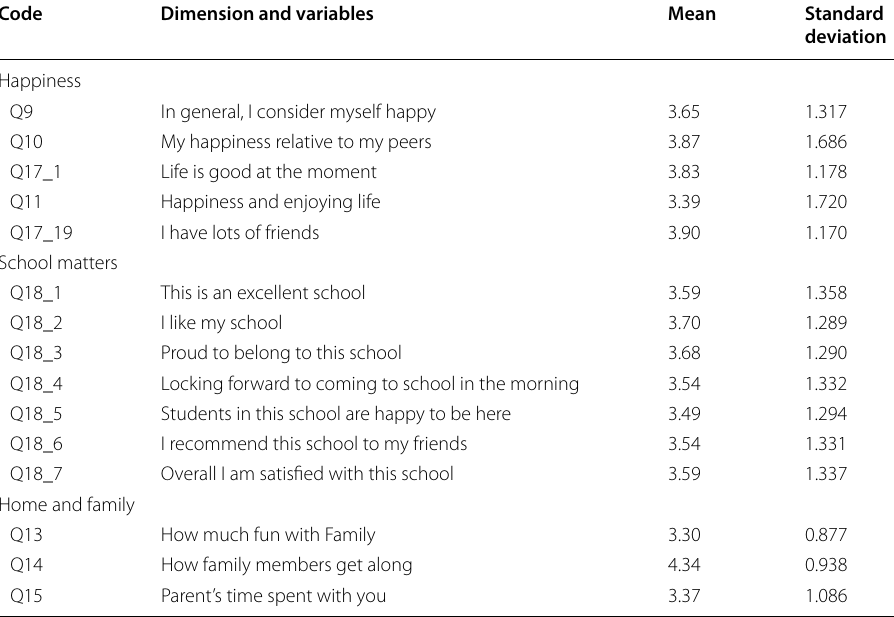
All mean (average) values are from minimum 1 to maximum 5